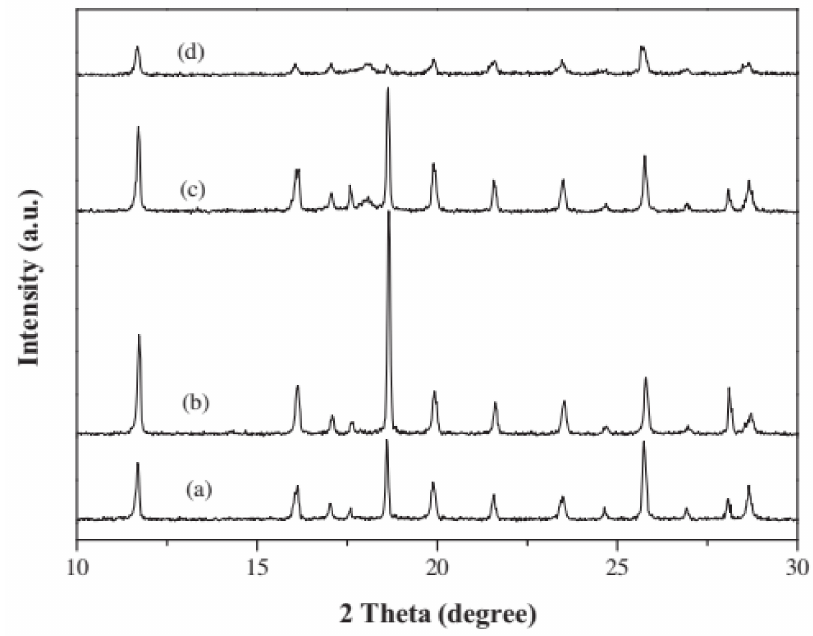
Figure 11. XRD patterns of catalyst samples: ( a ) fresh Co–MOF-A catalyst; ( b ) fresh Co–MOF- B catalyst; ( c ) Co–MOF-B catalyst after the first run; ( d ) Co–MOF-B catalyst after the fifth run. Reproduced with permission from